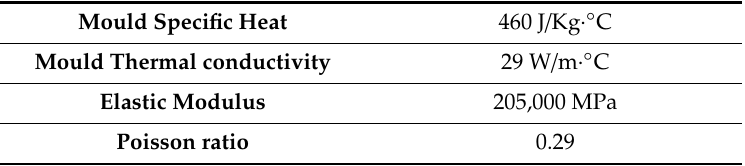
Table 3. Mechanical and thermal properties of P-20 tool steel.